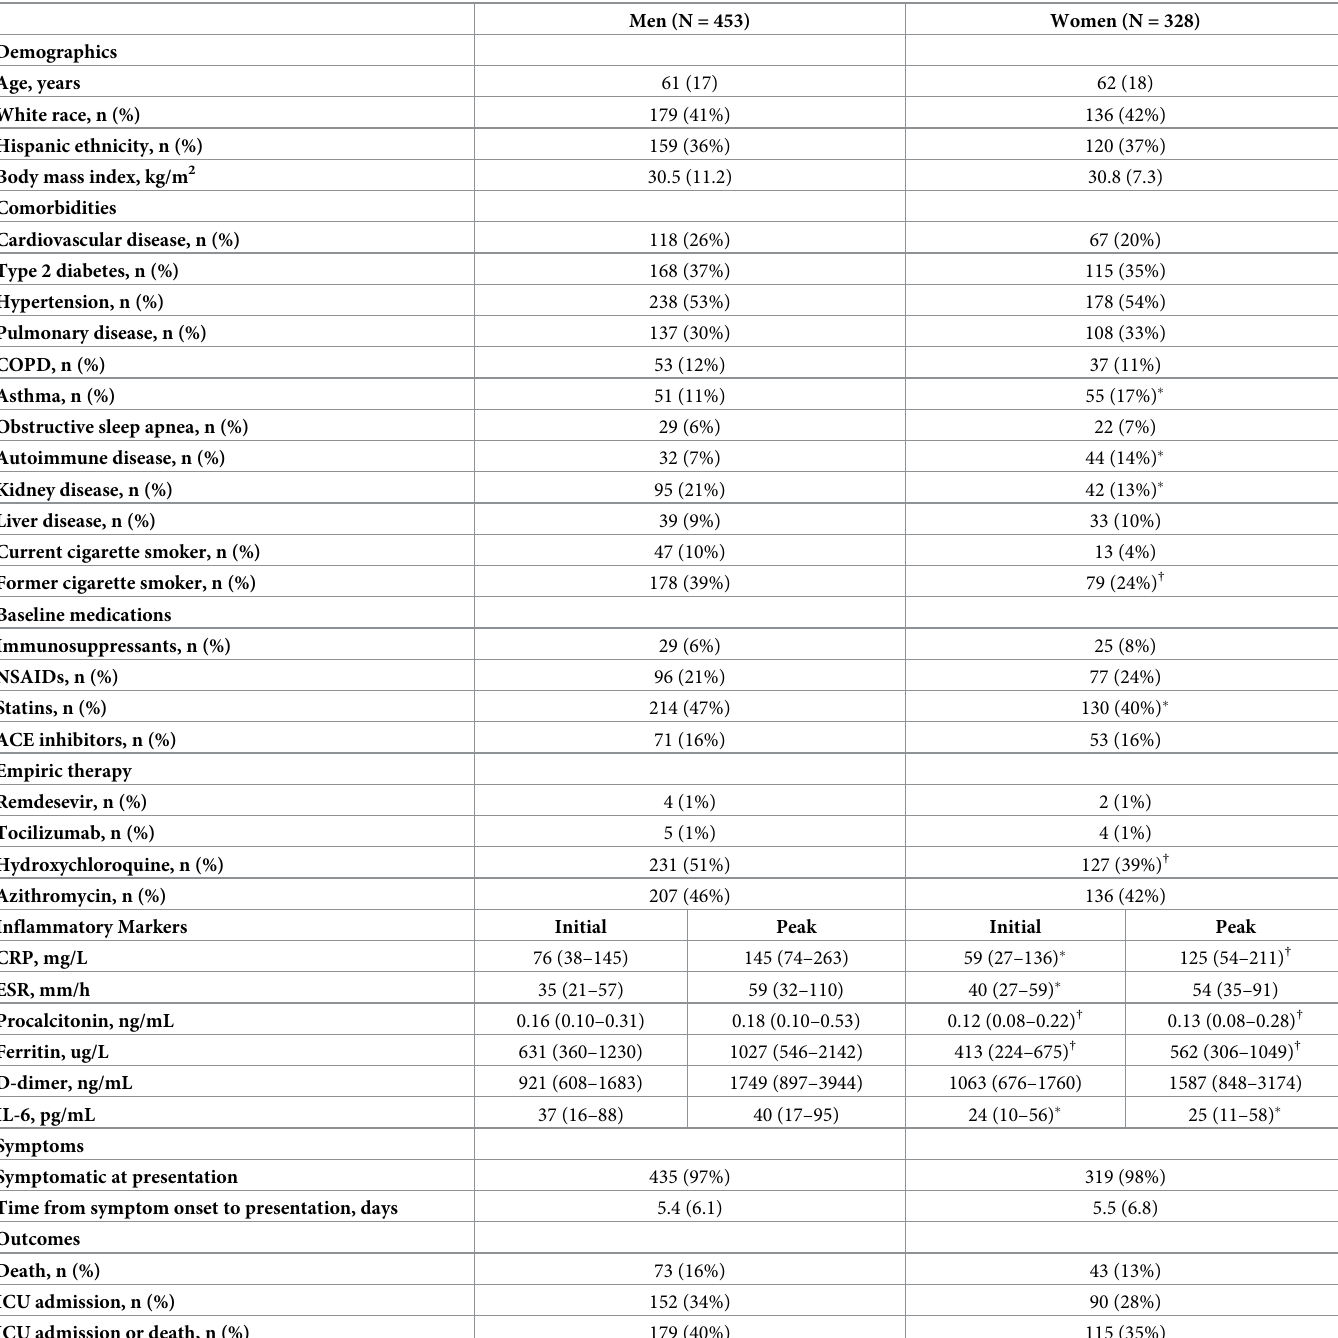
Table 1. Baseline characteristics, inflammatory markers, and outcomes in men and women with COVID-19